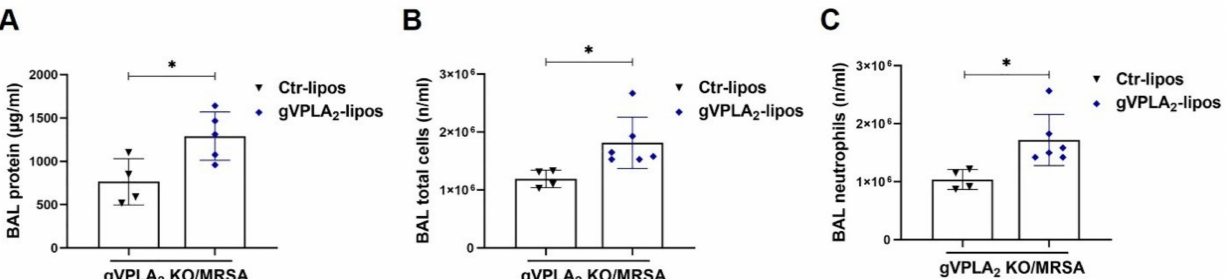
Figure 8. Exacerbation of MRSA-induced lung injury in gVPLA 2 KO mice by administration of ACE antibody-conjugated liposomes carrying gVPLA 2 plasmid. gVPLA 2 knockout (gVPLA 2 KO) mice were administrated intravenously ACE- conjugated liposomes containing either gVPLA 2 plasmid (gVPLA 2 -lipos) or empty vector (Ctr-lipos). Twenty-four hours later, mice were treated with live MRSA-USA300 (0.75 × 10 8 CFU/mouse) intratracheally. ( A ): total protein levels, ( B ) total cell counts, and ( C ) neutrophil counts were determined in the bronchoalveolar lavage (BAL) of mice 18 h after MRSA treatment. * p < 0.05. n = 4–6 mice/condition.